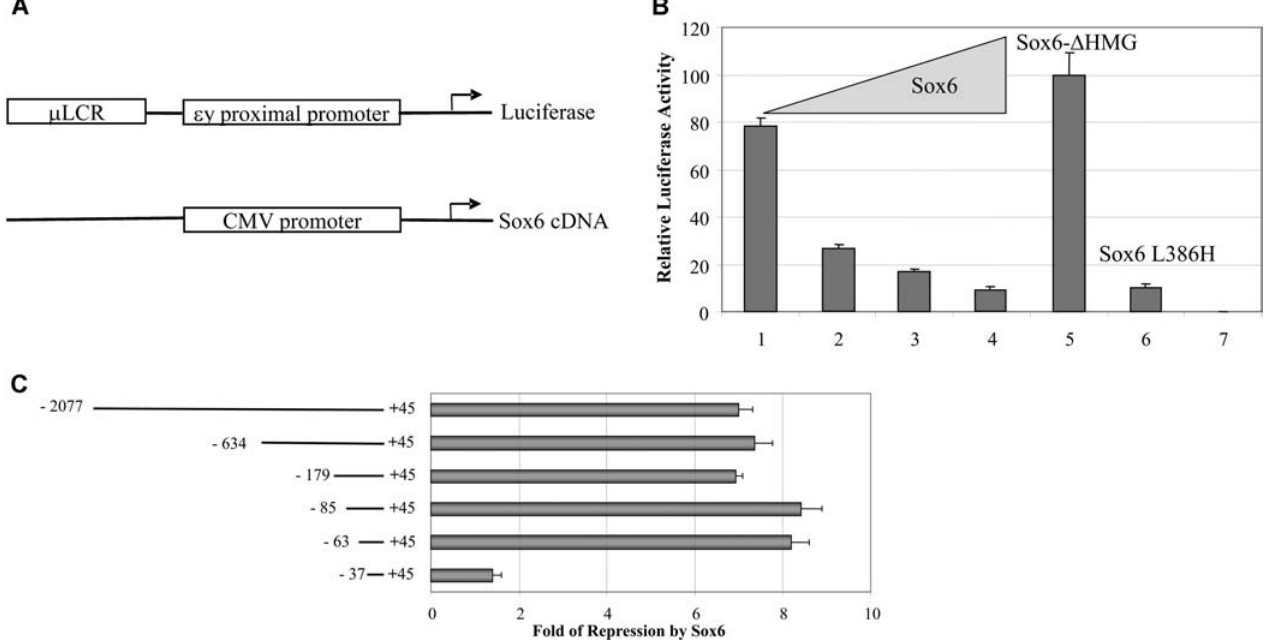
Figure 2. The Effect of Sox6 on the e y Promoter (A) Constructs of the e y promoter reporter (E-luc) and Sox6 overexpression vector. The E-luc reporter construct consists of a 2.5-kb l LCR element, a 2.2- kb e y proximal promoter, and the luciferase reporter in the pGL-3 basic plasmid (see Materials and Methods). Sox6 expression is driven by the CMV promoter. (B) Sox6 represses e y promoter activity in a dosage-dependent manner. In GM979 cells, the E-Luc e y promoter reporter construct was co-transfected (1) without overexpression of Sox6; (2–4) with increasing amounts of CMV-Sox6 overexpression vector; (5) with a truncated version of Sox6 that lacks its HMG domain; (6) with a mutant version of Sox6 (L386H) that has previously been shown to abolish interaction with CtBP2; or (7) with an empty reporter plasmid (without e y promoter and l LCR element). (C) Promoter deletion analyses to delimit the critical sequence. The 2.2-kb proximal promoter or deletions of it, as indicated on the left (numbering relative to þ 1 ¼ the transcription start site of e y globin, see Materials and Methods), were engineered in reporter constructs as in (A) and were transfected along with CMV driven Sox6 to GM979 cells (see Materials and Methods for details). The relative repression by Sox6 on the activity of the different reporter constructs is shown. All experiments were done in triplicate. DOI: